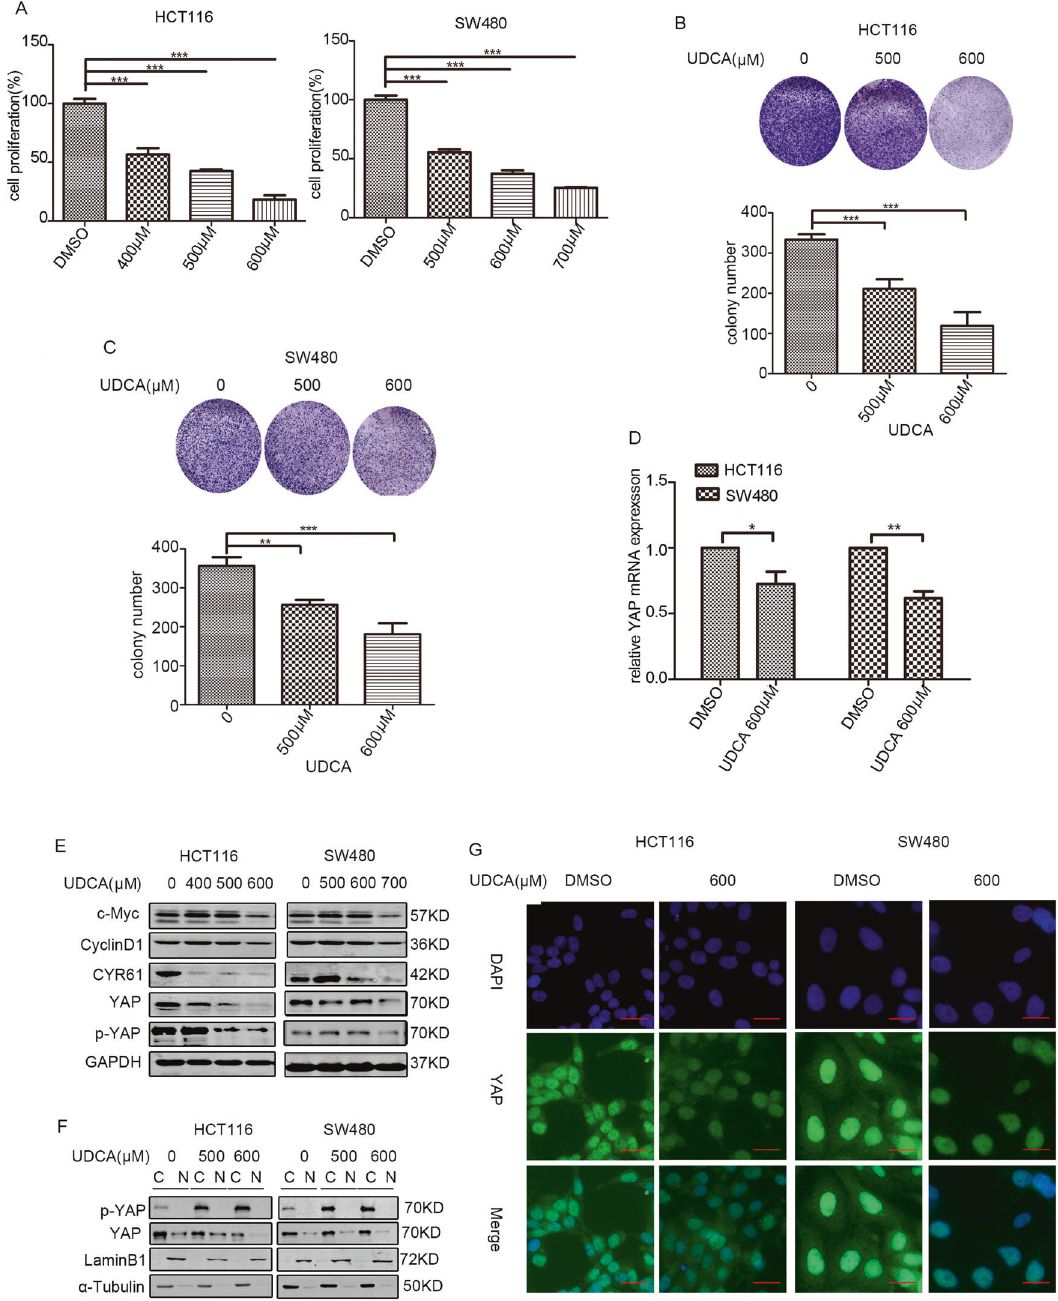
Fig. 1 UDCA regulates expression of YAP and Hippo pathway target genes. A UDCA-induced inhibition of cell proliferation was measured using MTT assays after treatment for 36 h. Data are demonstrated as the mean ± SD, * p < 0.05, ** p < 0.01, and *** p < 0.001 with Student ’ s t test (two-tailed). B , C Clonogenic assays and qualitative analysis of the HCT116 and SW480 cells cultured with the indicated concentration of UDCA at day 14. D YAP mRNA levels in HCT116 and SW480 cells were measured with quantitative real-time RT-PCR, and normalized to GAPDH. Data are demonstrated as the mean ± SD, * p < 0.05, ** p < 0.01, and *** p < 0.001 with Student ’ s t test (two-tailed). E WB for c-Myc, cyclinD1, p-YAP, YAP, and CYR61 in the HCT116 and SW480 cells treated with UDCA for 36 h. F WB results showing YAP expression in cytoplasmic and nuclear protein extracts from HCT116 and SW480 cells treated with DMSO or UDCA (500 μ M and 600 μ M) for 36 h. G HCT116 and SW480 cells were treated with 600 μ M UDCA for 36 h, and YAP expression was visualized by IF staining with anti-YAP antibody (green). DNA was stained using DAPI (blue). Scale bar: 25 μ